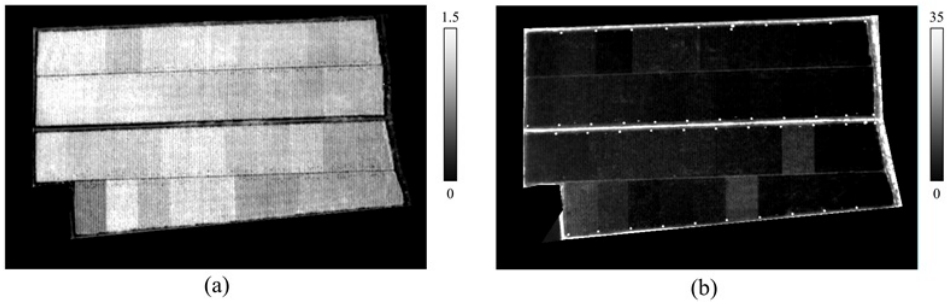
Figure 6. The abundance images of ( a ) foreground and ( b )